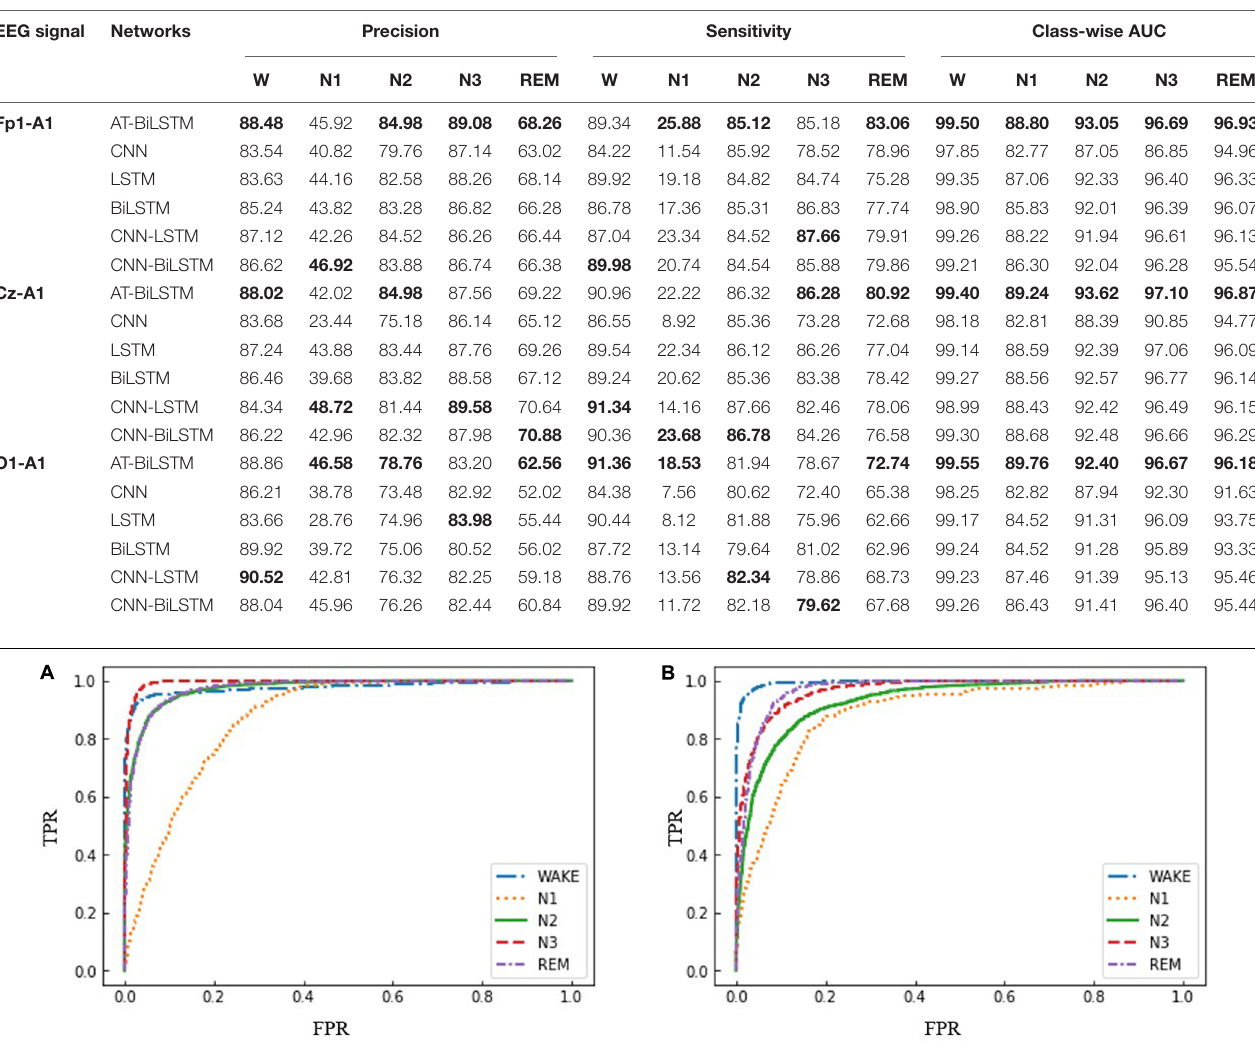
TABLE 6 | The class-wise performance obtained on the DRM-SUB dataset (value in bold represents for the best among all the networks). EEG signal Networks Precision Sensitivity Class-wise AUC